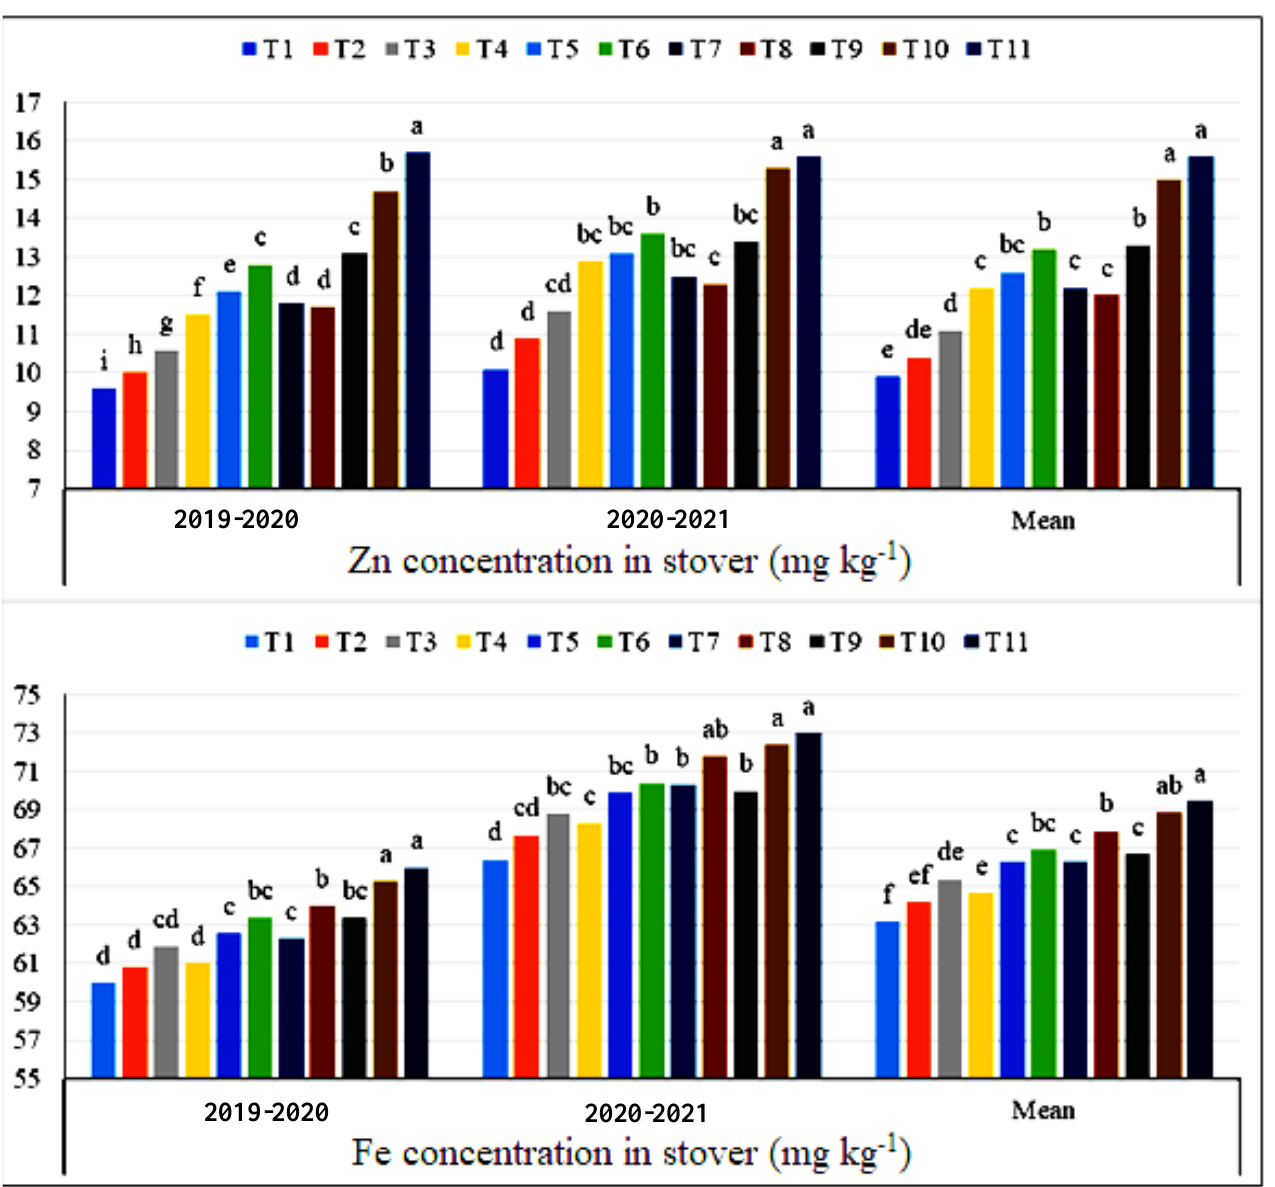
Figure 4. Effect of micronutrient and urea spray-on Zn and Fe content (mg kg − 1 ) in stover of Indian mustard. Treatments details are available in Table 1. The bar with a similar or dissimilar letter(s) was evaluated with the least significant difference (LSD) multiple range tests using a probability level of p ≤ 0.05.